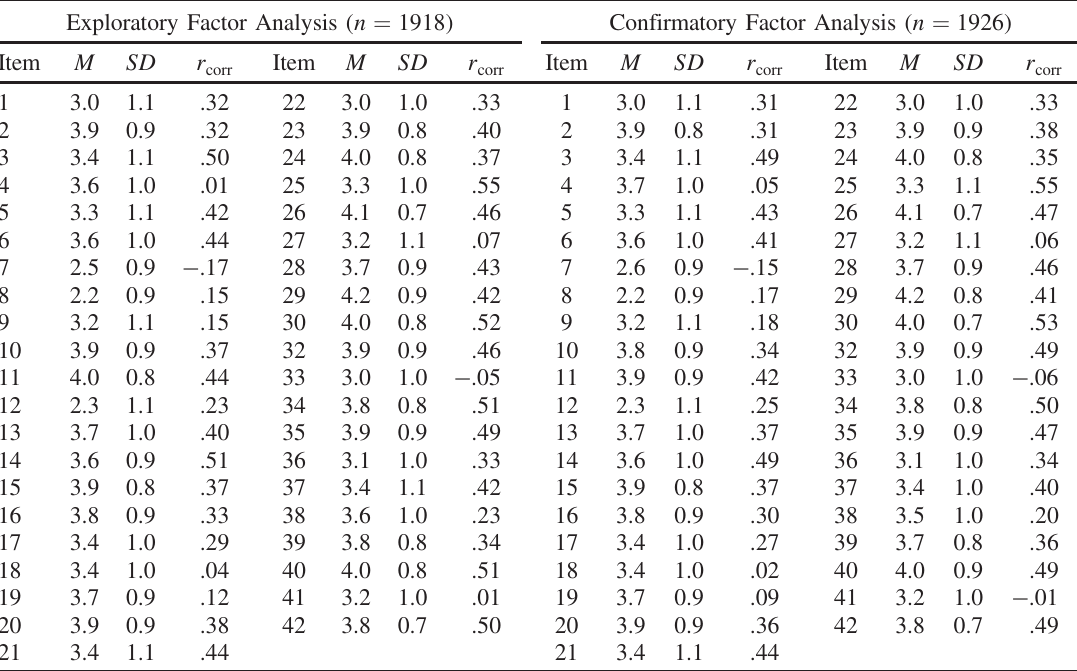
TABLE I. Univariate summary statistics and item-total correlations of the CLASS. Exploratory Factor Analysis ( n ¼ 1918 ) Confirmatory Factor Analysis ( n ¼ 1926